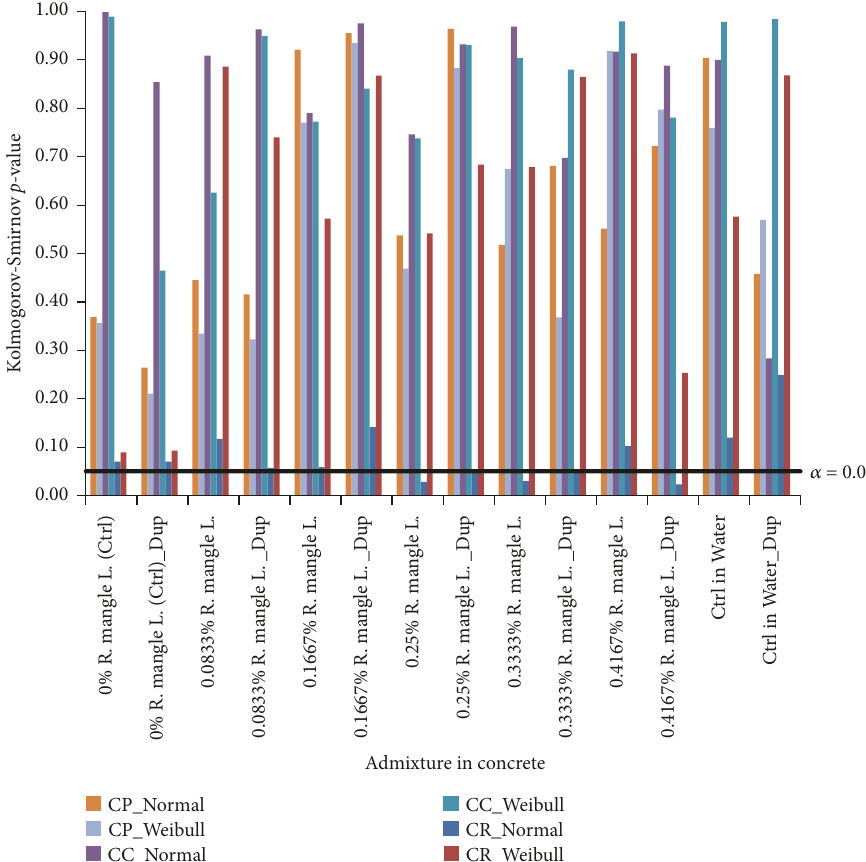
Figure 2: Test-results of compatibility of datasets of corrosion test-variables to the Normal distribution and to the Weibull distribution by the Kolmogorov-Smirnov goodness-of-fit statistics.